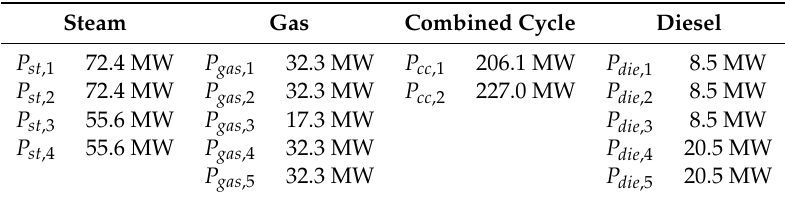
Table 1. Gran Canaria thermal units power.